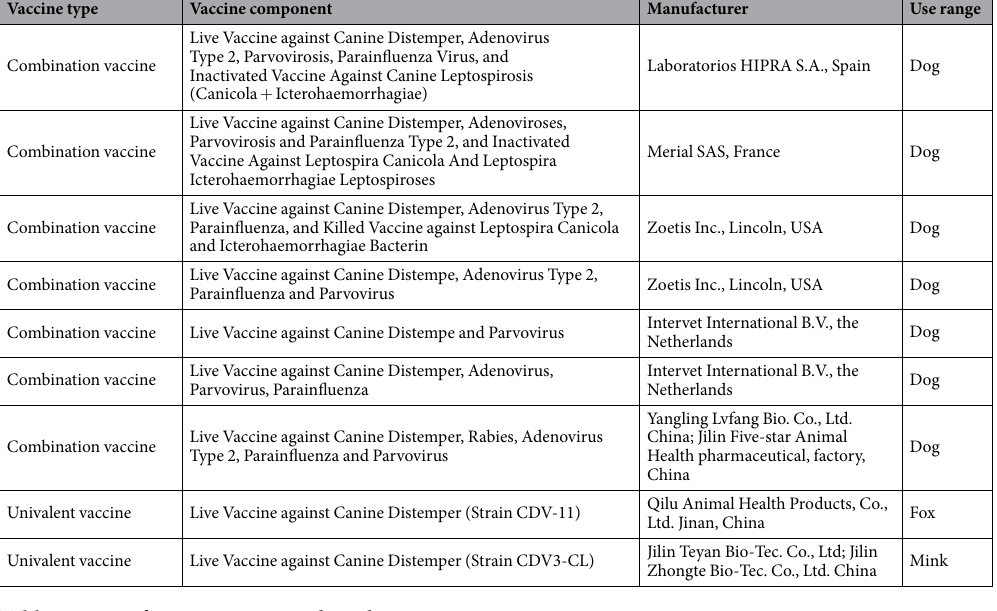
Table 1. Lists of CDV vaccines used in